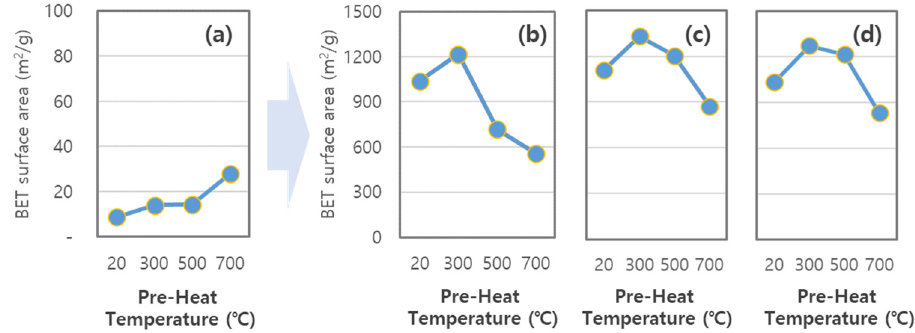
Figure 4. Relationship between the surface area and Pre-Heat temperatures by ( a ) CM-DTH and CM-DTHC with sample to KOH ratio ( b ) 1:1, ( c ) 1:2, and ( d ) 1:3.